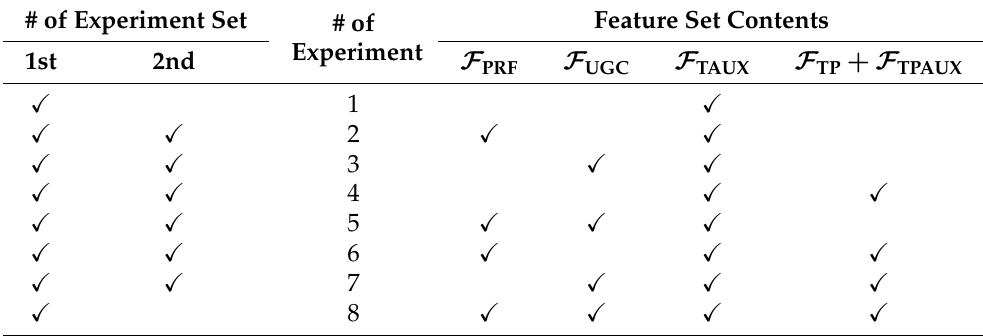
Table 8. Sets of features used for